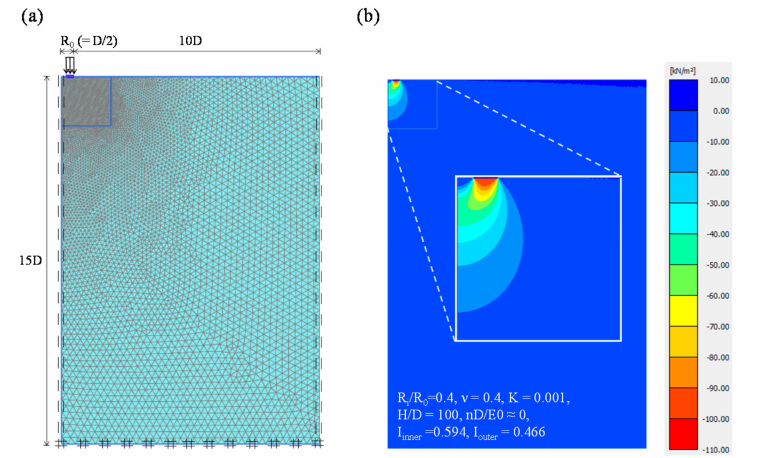
Figure 2. Illustration of ( a ) FE mesh used in this study, and ( b ) vertical stress distribution in soil mass.